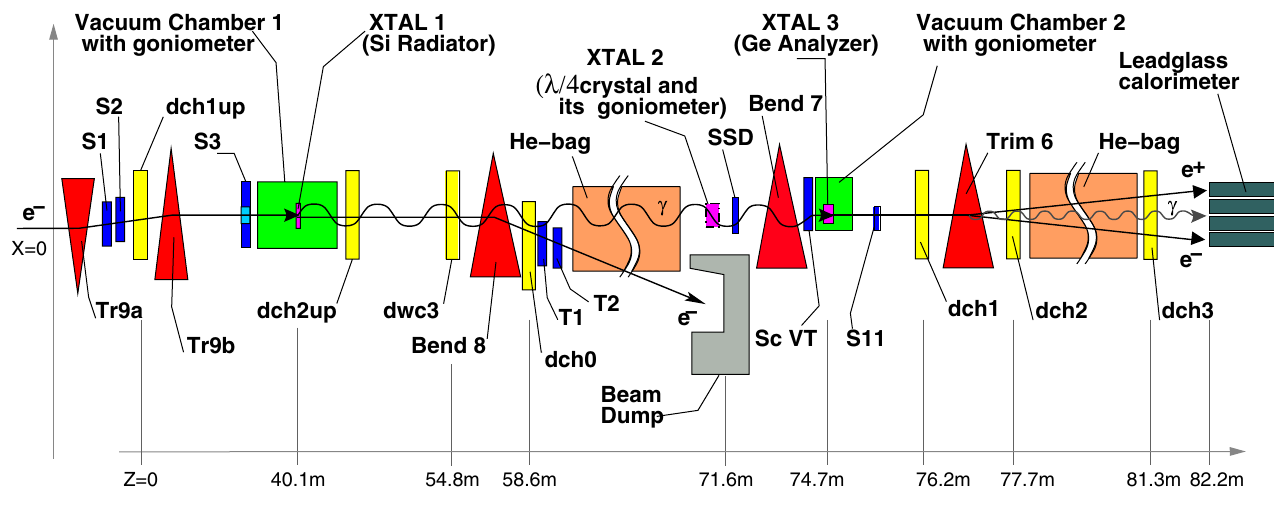
FIG. 9. (Color) The experimental